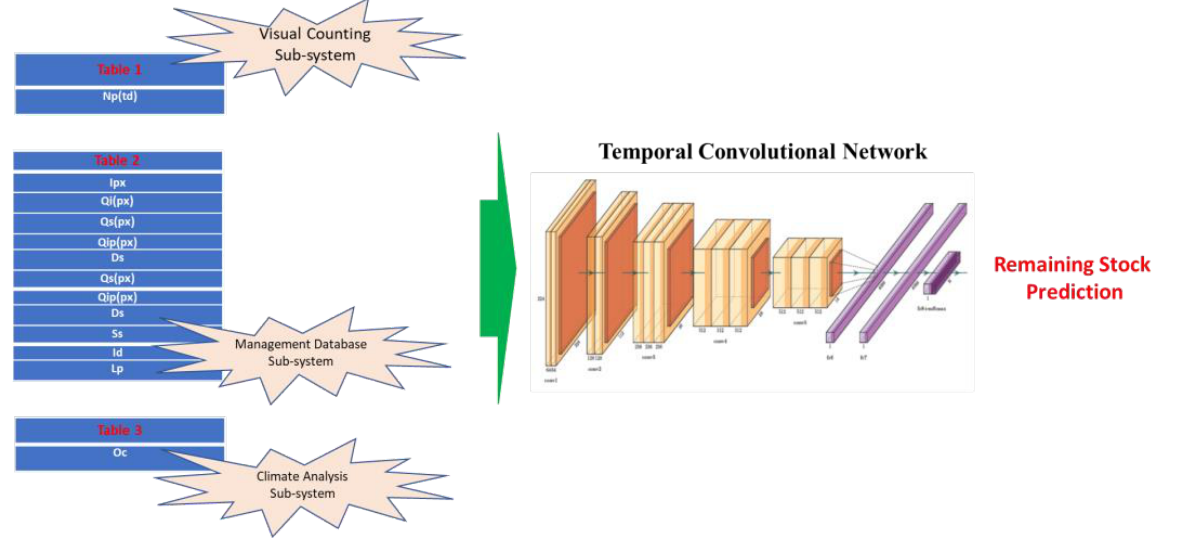
Figure 4. The proposed downstream deep regressor .